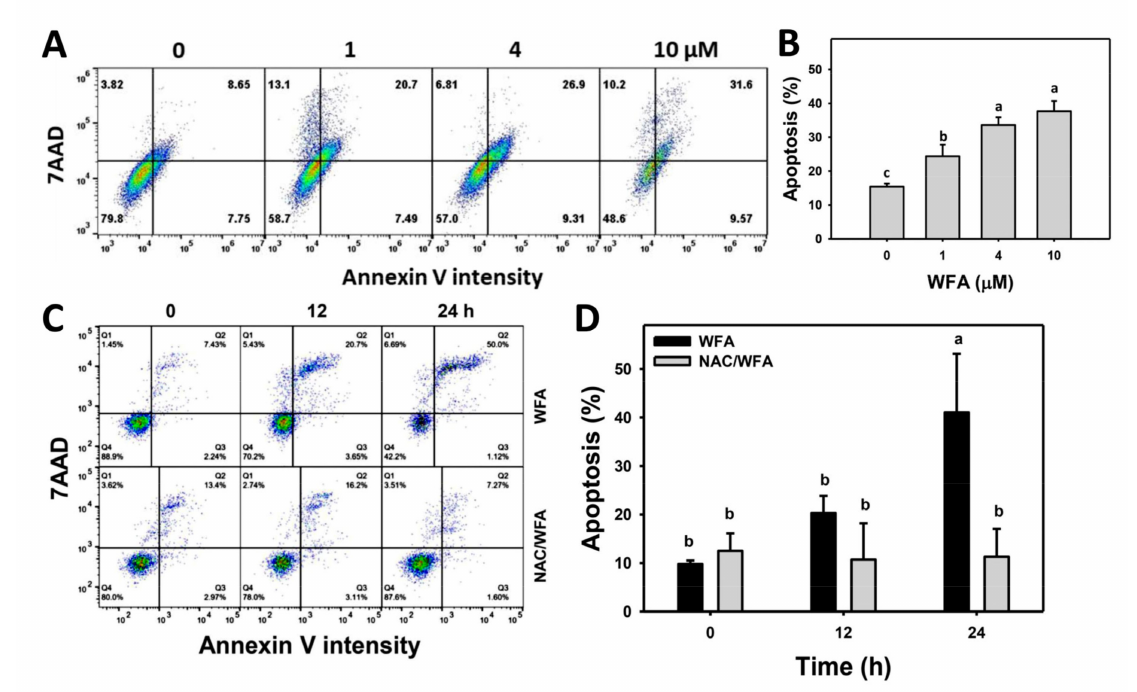
Figure 3. WFA induces apoptosis in bladder cancer cells. ( A , B ) Patterns and statistics for annexin V change. Bladder cancer cells (J82) were treated with WFA (24 h, 0 to 10 µ M), where the negative control for WFA (0 µ M) contained 0.1% DMSO. Annexin V (+)/7AAD (+/ − ) populations (%) were regarded as apoptosis (%). ( C , D ) Pattern and statistics for the NAC pretreated effect on annexin V expression of J82 cells were identified following WFA incubation. Cells were pretreated and post treated with NAC (8 mM, 1 h) and WFA (0 and 10 µ M for 12 and 24 h), respectively. Data, mean ± SD ( n = 3). Columns showing non-overlapping lower-case letters indicate p < 0.05 for multiple